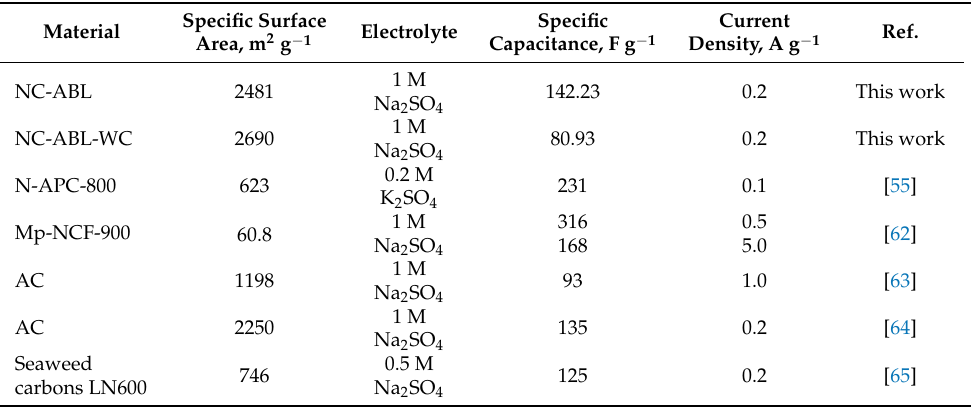
Table 3. Comparison of specific capacitance of various carbon-based materials.